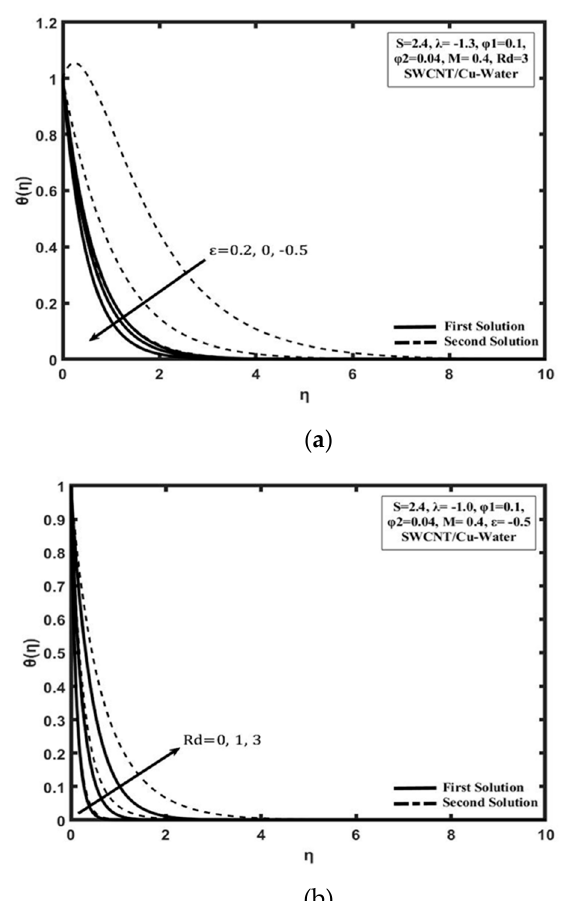
Figure 7. Temperature profile θ ( (cid:2015) ) when S = 2.4, (cid:2019) = −1 , (cid:2030) (cid:2869) = 0.1, (cid:2030) (cid:2870) = 0.04, M = 0.4, ε = − 0.5, Gr = 0: ( a ) with different ε ; ( b ) with different Rd . Gr = 0: ( a ) with different ε ; ( b ) with different Rd